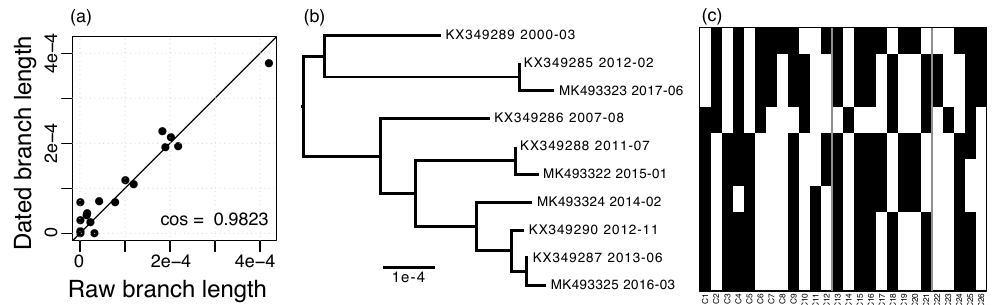
Figure 2. RIM8 dating. ( a ) Agreement of raw branch lengths and branch lengths dated with LSD, straight line gives the identity; ( b ) Dated phylogeny estimated with LSD, accessions, and sampling dates are given; ( c ) Presence–absence matrix of variable genes, rows are ordered by the phylogeny shown in ( b ) and columns are ordered by alignment position (see also Table S2); the three regions of variable genes are separated by gray